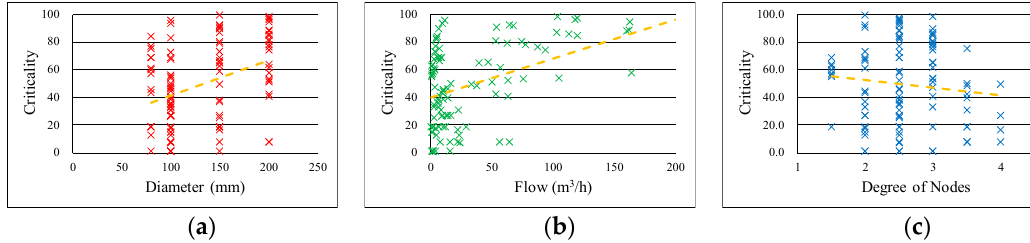
Figure 9. Relation of OVERALL criticality with ( a ) diameter, ( b ) flowrate, and ( c ) DoN pipe for Network 1.